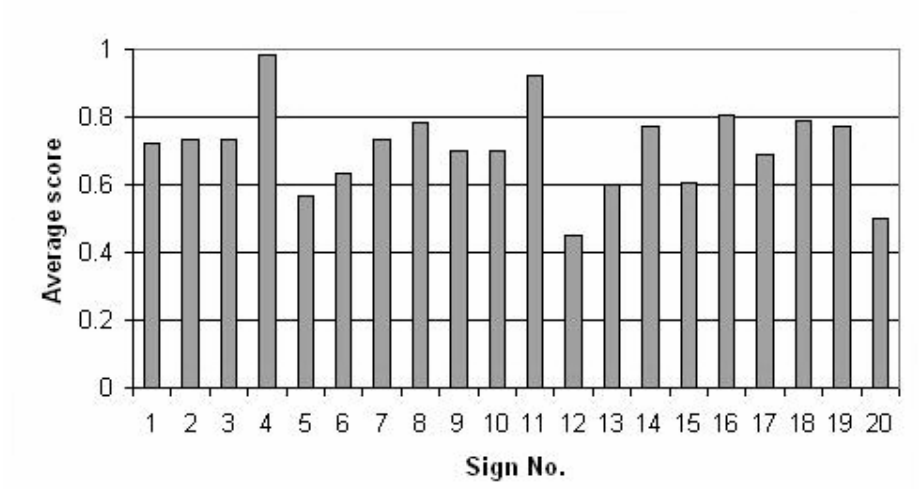
Figure 4. Average Interview Scores for each